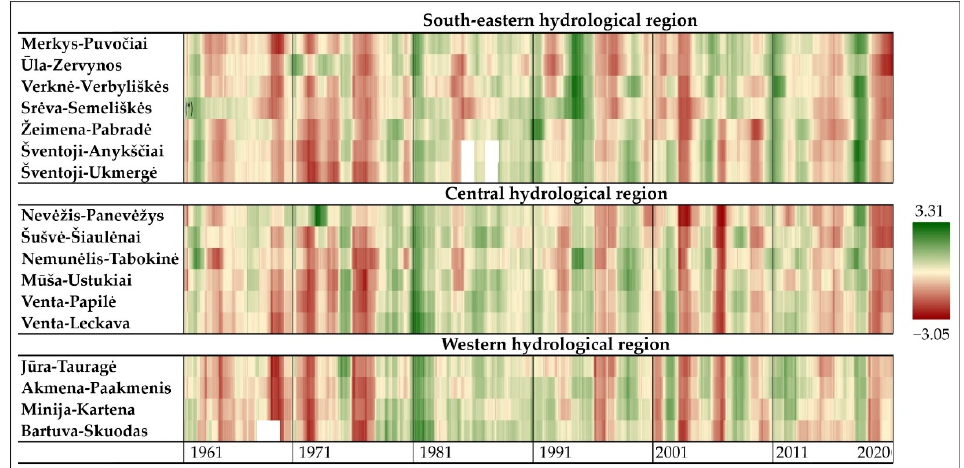
Figure 6. Graphical representation of the SDI-12 index calculation results in 1961–2020, where green indicates wet months and red indicates dry months, white—no data, the magnitude of the events depends on the brightness of the color.